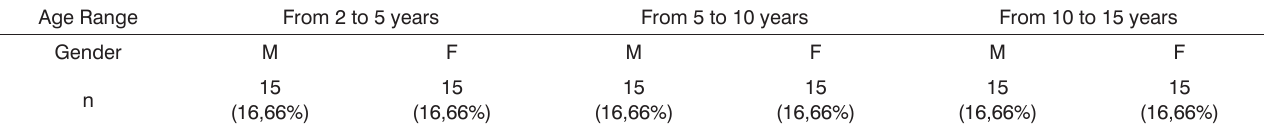
Standardizing Food Consistency